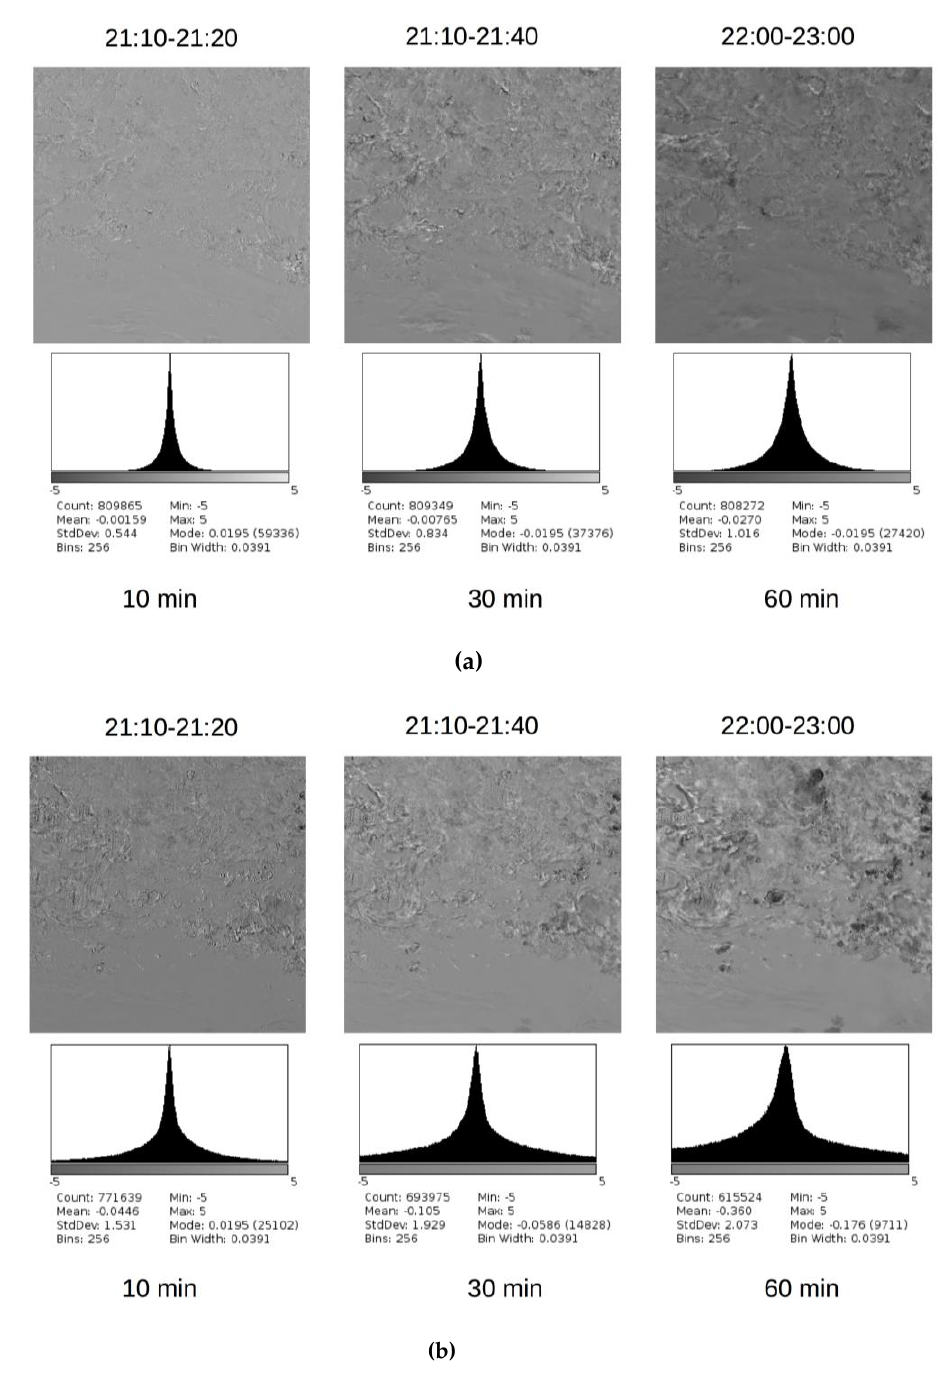
Figure 8. ( a ) ∆ ( BT 10.4 − BT 11.2 ) ; ( b ) ∆ ( BT 3.9 − BT 10.4 ) images. Histogram values, referring to time intervals of 21:20 – 21:10 UTC ( ∆ t = 10 min), 21:40 – 21:10 UTC ( ∆ t = 30 min), 23:00 – 22:00 UTC ( ∆ t = 60 min), are reported at the bottom of each panel.